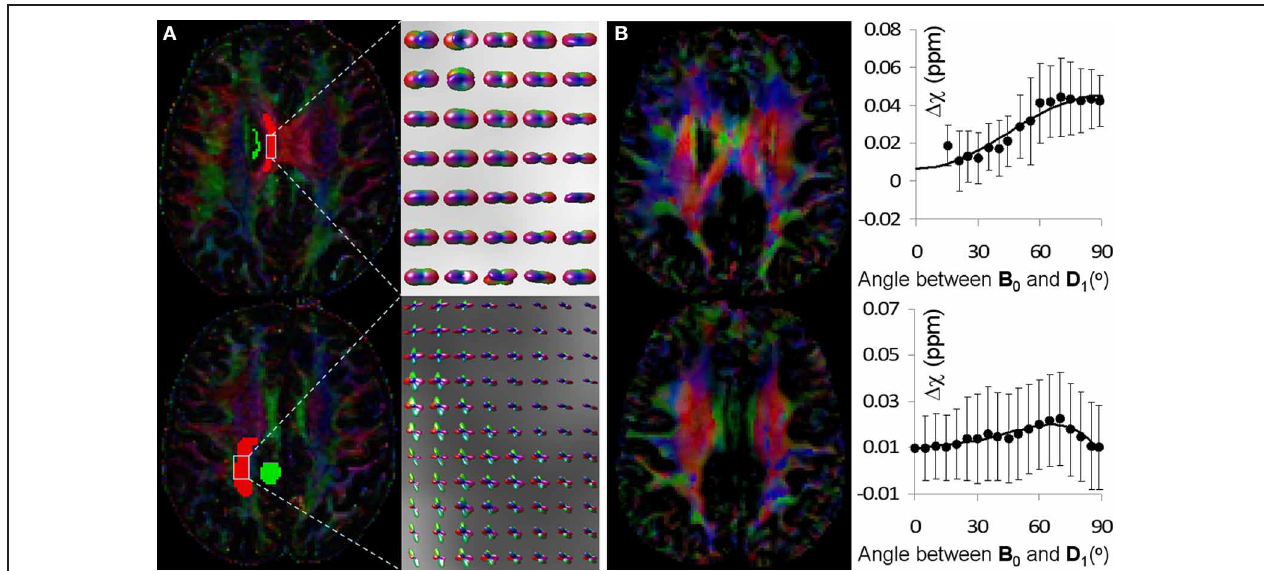
crossings were extensive and clearly visible in the PDF glyphs. (B) STI eigenvector orientation map (left) and corresponding AMSplot as a function of fiber angle over the same ROI in (A) . AMSwascalculated using the adjacent green ROI asa reference to reduce global heterogeneity of magnetic susceptibility. Fiber angles were computed as the angles between DTI fiber orientations and the B 0 field